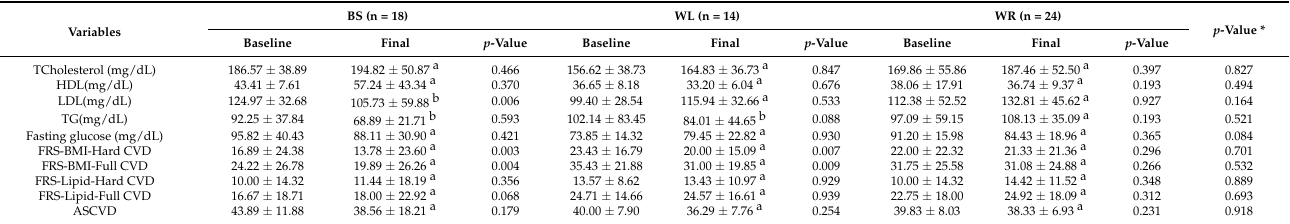
Table 5. Changes in CVD risk among study groups.